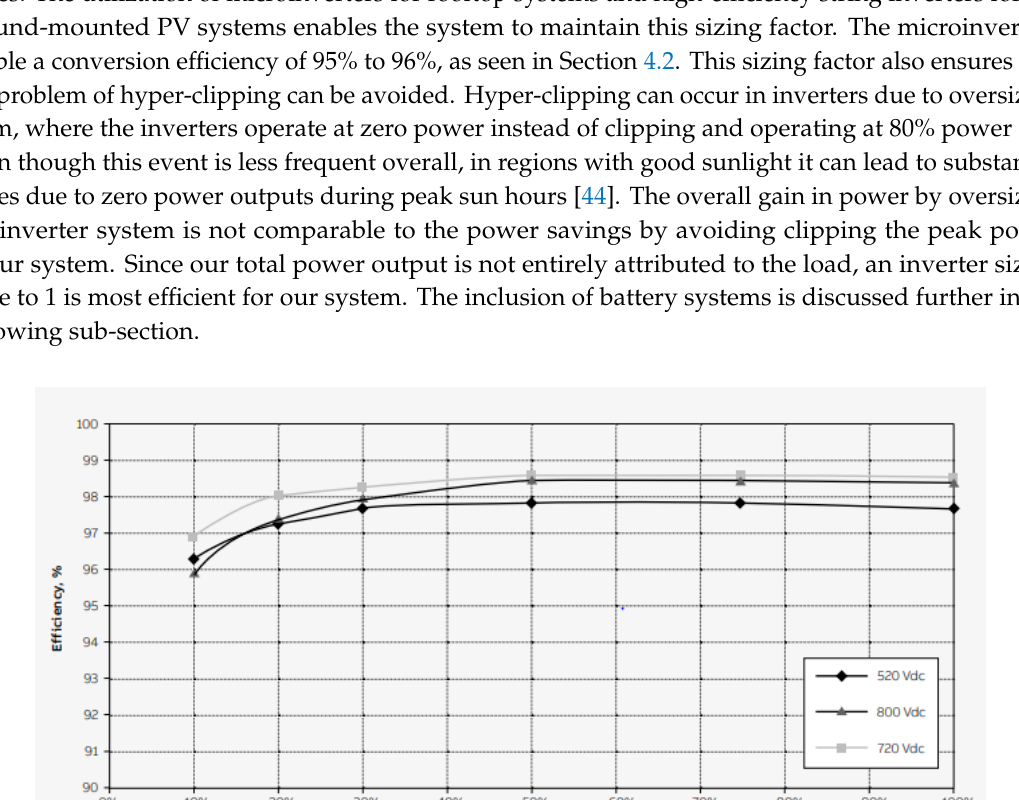
Table 2. Sunny Tripower Core1 (STP-33-US-41) inverter specifications [42]. Metric Value